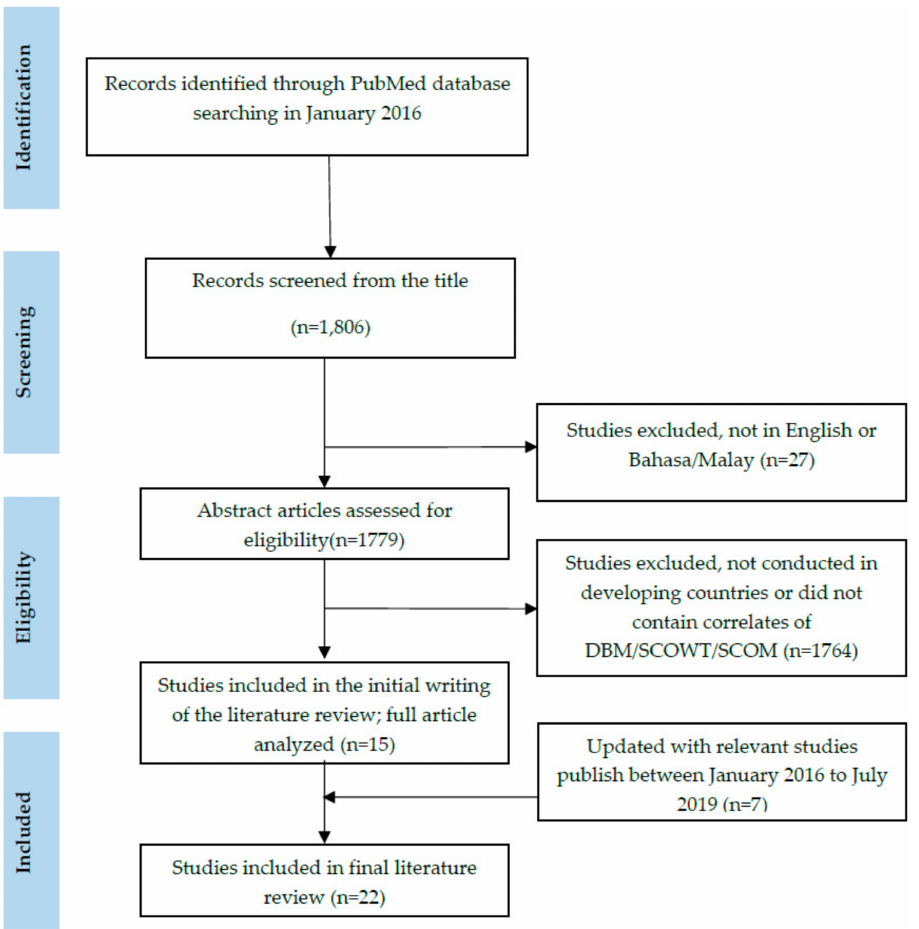
Figure 3. Flow chart of the study included in the literature